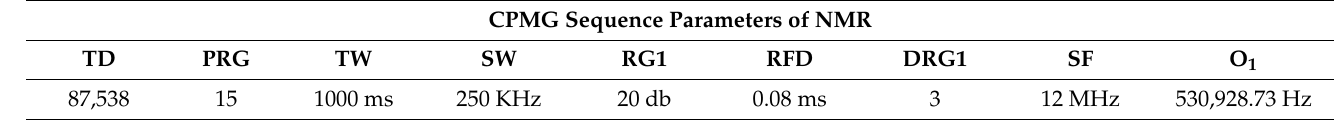
Table 3. CPMG sequence parameters of coarse-grained soil porosity test.